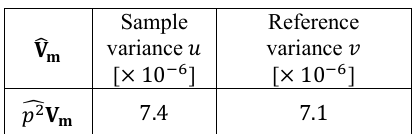
Table 4. Comparison between sample variance 𝑢 and the reference variance 𝑣 in the first